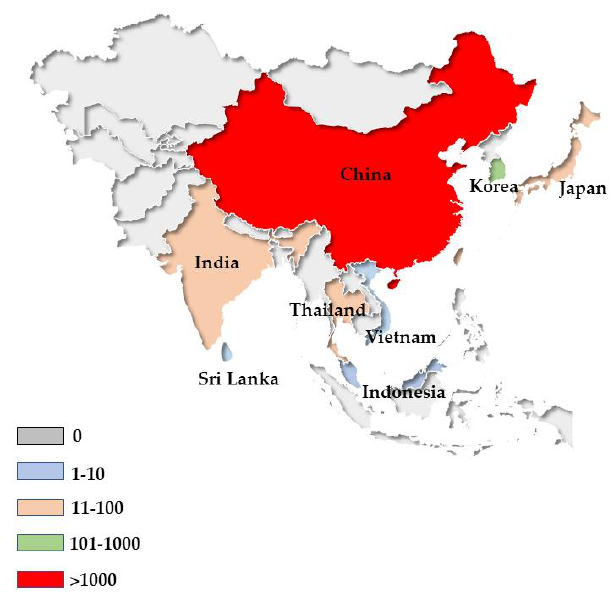
Figure 4. Geographical distribution of human sparganosis in